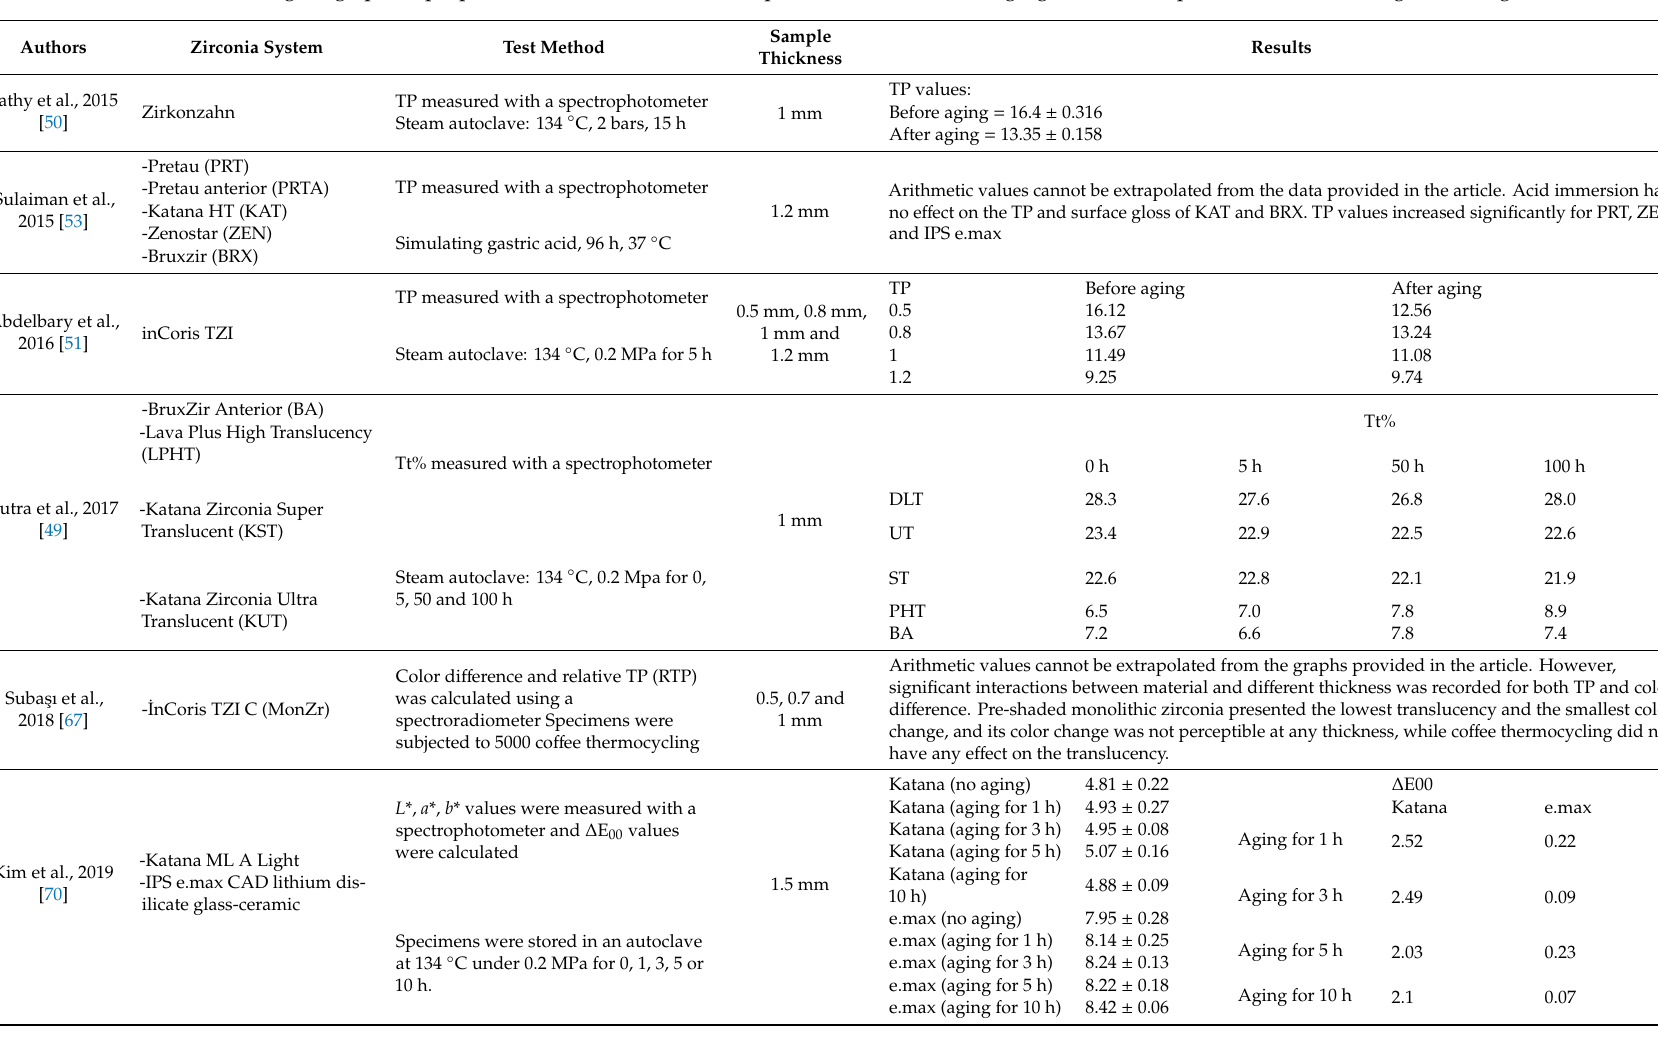
Sample Thickness